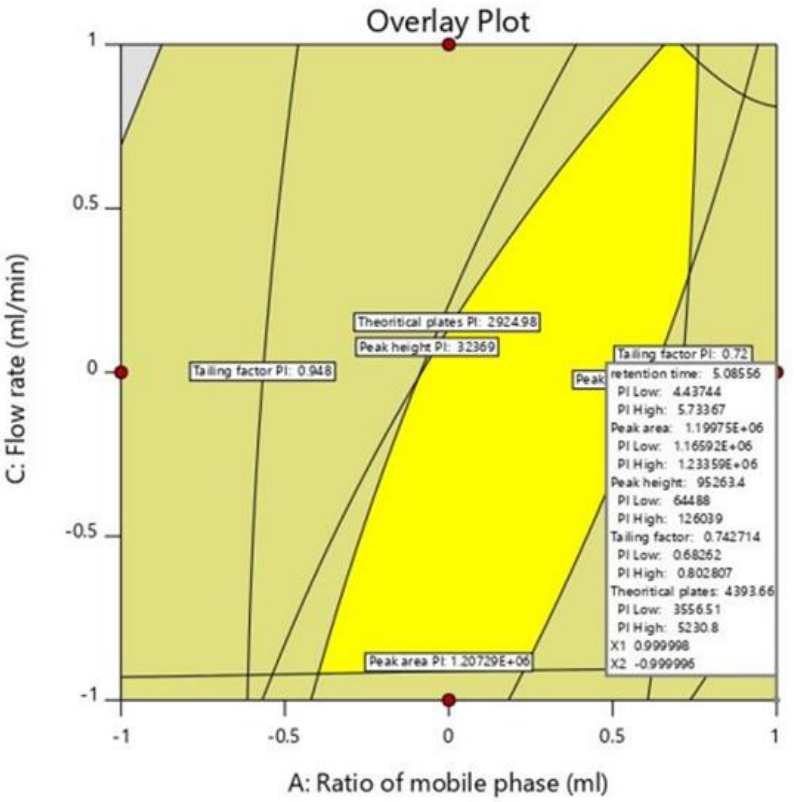
Figure 5. An overlay plot depicting the optimized method conditions for estimating XH. The obtained value of retention time, peak area, peak height, tailing factor and theo- retical plate were found to be 5.392 min, 1,226,737 mAU, 90,121 AU, 0.991 and 4446.667 cm, respectively. The p value between predicted values and obtained values for all the parameters were found to be more than 0.05, indicating non-significant variation and thus validating the experimental design for having excellent correlation between predicted and actual values. Thus, the adaption of a systematic AQbD method to achieve the best possi- ble analytical solution under competing objectives might be credited to such perfect chro- matographic results. It not only assisted in achieving the best analytical results but also revealed the underlying factor response connection. The typical HPLC chromatogram of XH obtained through the optimized method is shown in Figure 6A.